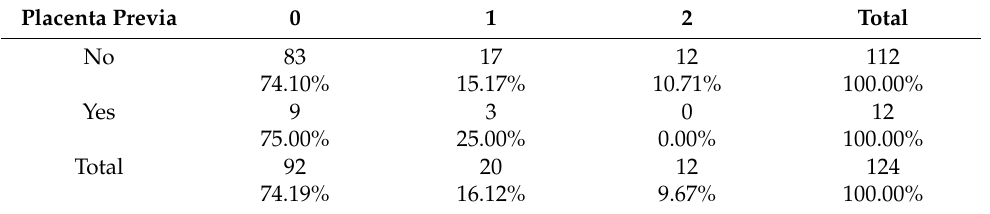
Table 20. The proportions of PUUS values of patients regarding the presence/absence of placenta previa, after removing the only case of PUUS = 4 and the few cases of PUUS = 3 (6 cases). Placenta